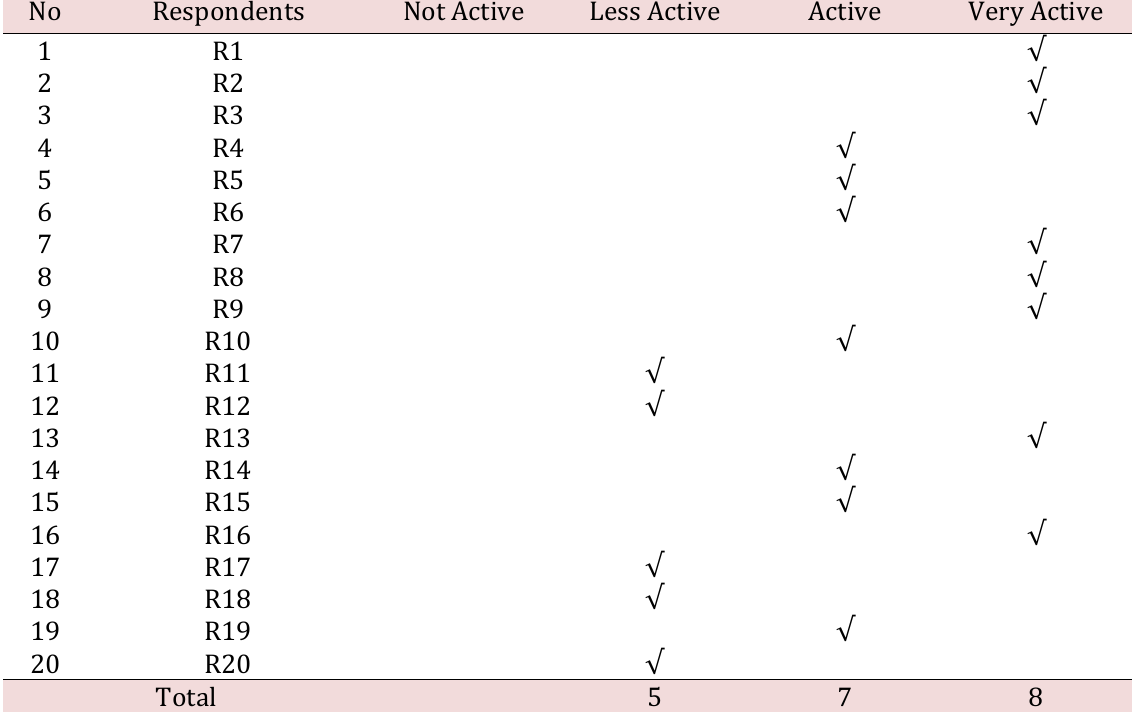
Figure 4. Diagram the Students' Participation in cycle